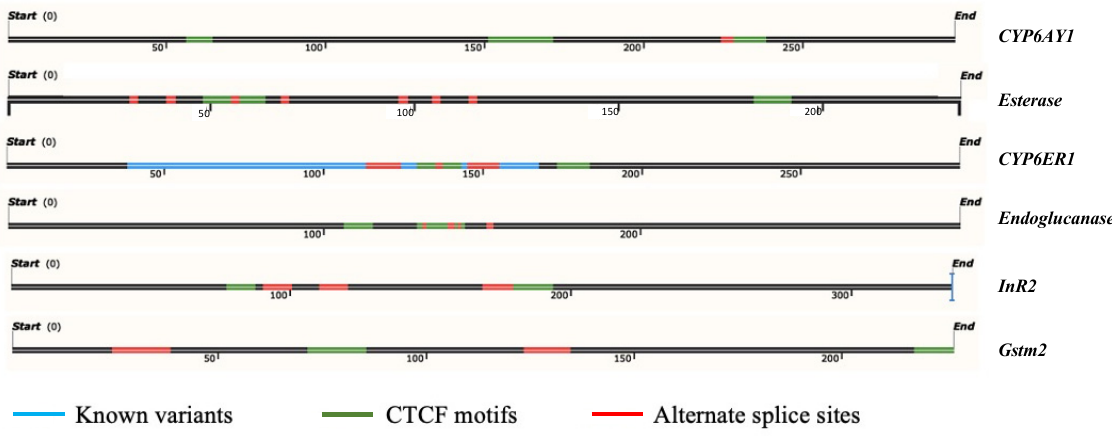
Figure 3. Diagrammatic representation of the location of regulatory motifs detected within the CpG islands, corresponding to stress-responsive genes in BPH. Numbers represent nucleotide position in the sequences.